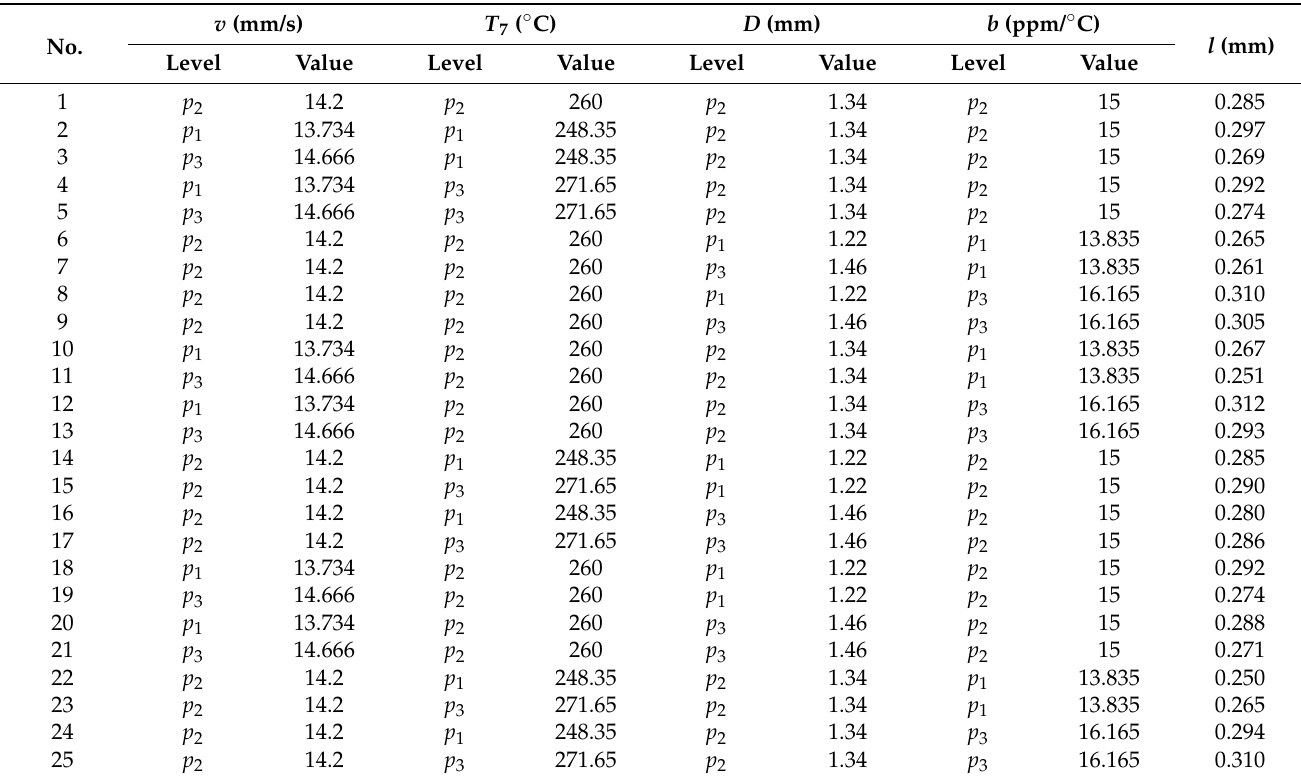
Table 5. Samples of Box–Behnken method and response